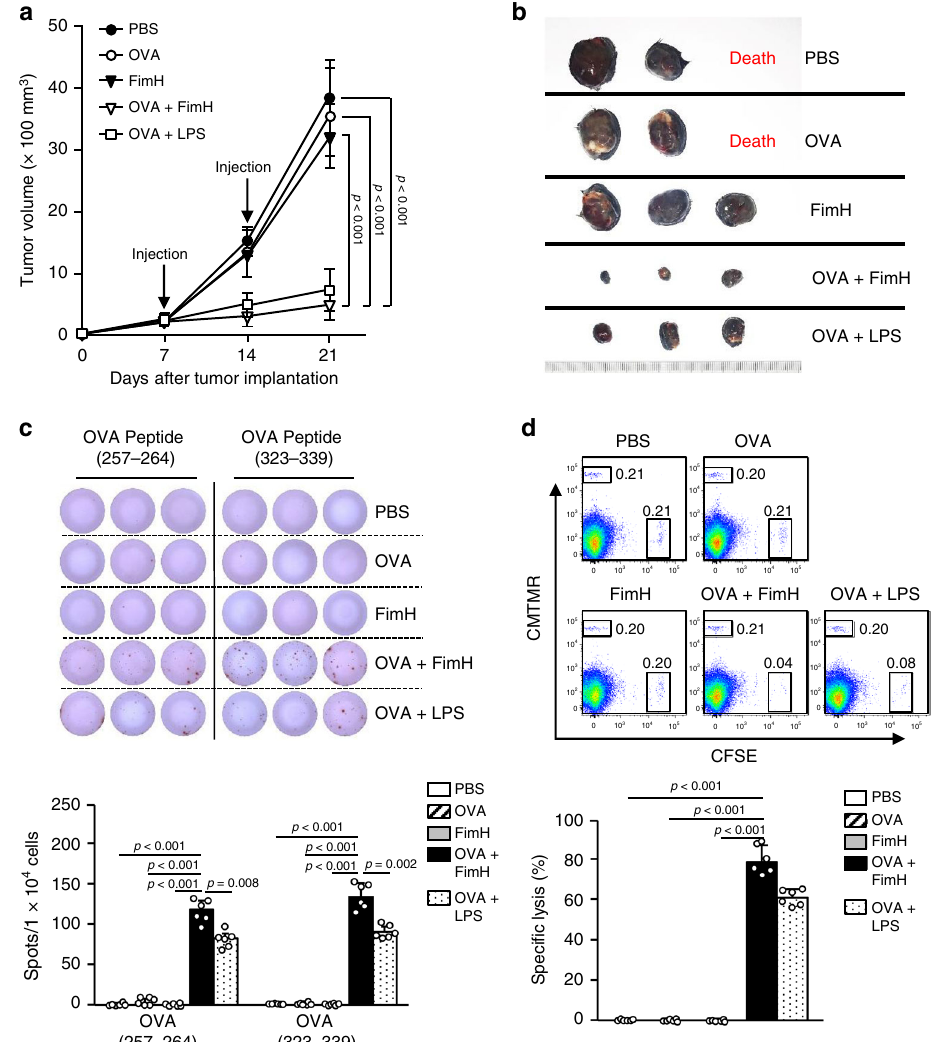
Fig. 4 Combined OVA and FimH treatment inhibits B16-OVA tumor growth. C57BL/6 mice were injected s.c. with 1 × 10 6 B16-OVA cells on the right side. After 7 and 14 of tumor-cell injection, the mice received s.c., 2.5 mg per kg of OVA, 2.5 mg per kg of FimH, or a combination of OVA and FimH in PBS. a The B16-OVA tumor growth curves are shown. ( n = 6 mice, signi fi cance determined by the log-rank test, mean ± SEM. b Representative tumor masses on day 21 are shown. ( n = 6 mice). c OVA peptides (257 – 264) and (323 – 339) speci fi c IFN- γ production in iLN cells were measured by ELISpot analysis (upper panel). The mean numbers of spots are shown (lower panel). ( n = 6 mice, one-way ANOVA, mean ± SEM). d Ag-speci fi c cytotoxic activity was measured in the mouse in vivo. Dot plots showed the percentages of SIINFEK-loaded CFSE + cells and CMTMR + cells not loaded with peptide (upper panel). The mean percentages of Ag-speci fi c lysis are shown (lower panel). ( n = 6 mice, one-way ANOVA, mean ±